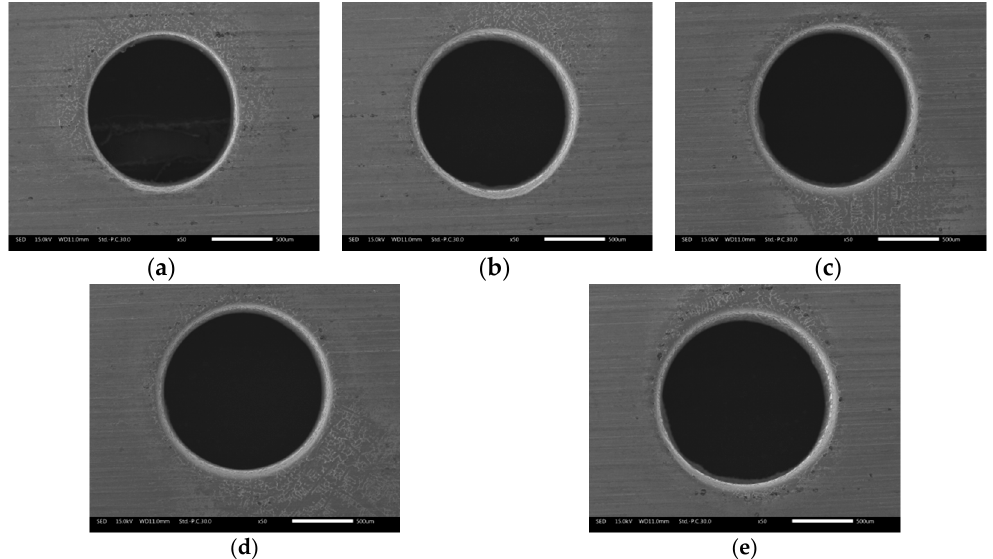
Figure 20. Exit morphology of holes after electrochemical reaming for different durations: ( a ) 5 s; ( b ) 10 s; ( c ) 15 s; ( d ) 20 s; ( e ) 25 s.